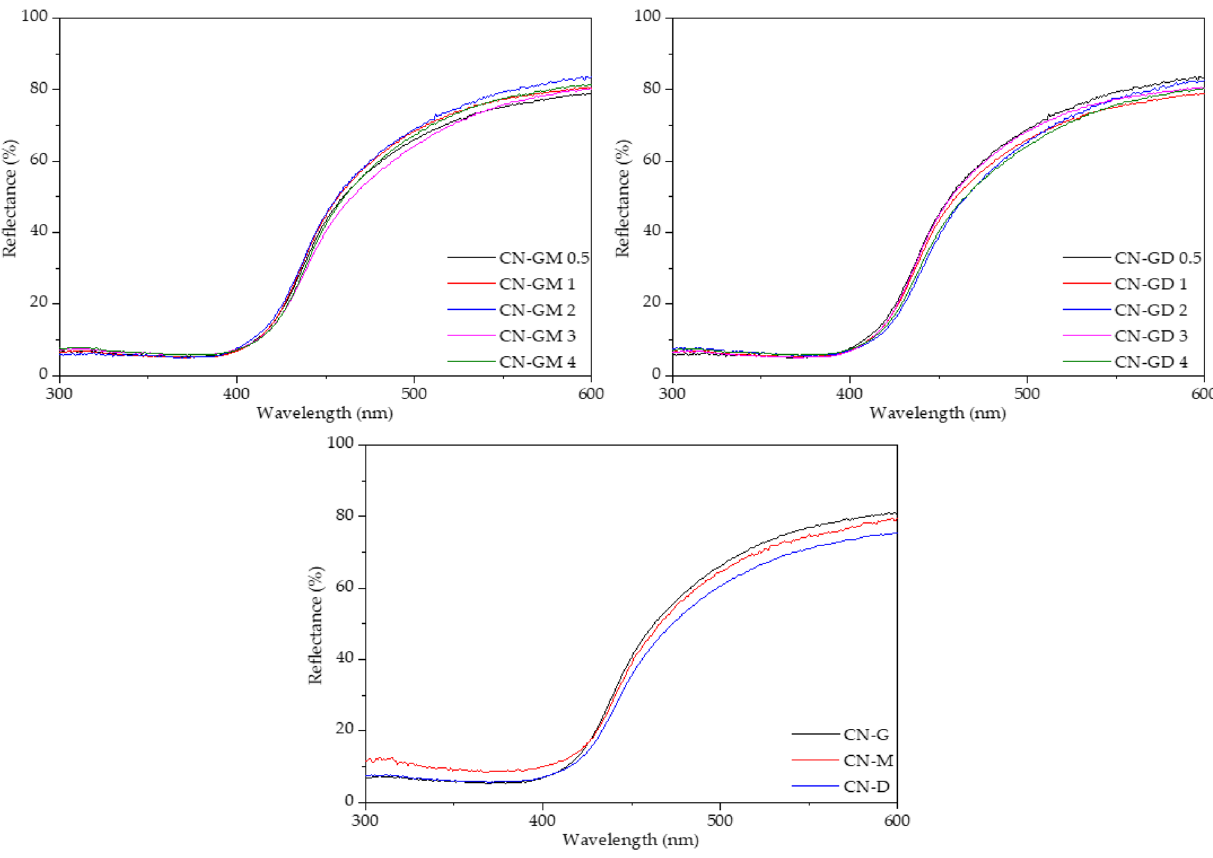
Figure 1. UV–Vis diffuse reflectance spectra of CN materials.